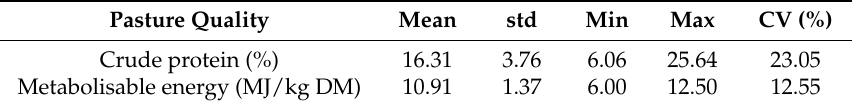
Table 1. Descriptive statistics: mean, standard deviation (std), minimum (min), maximum (max), and coefficient of variation (CV) pasture quality data was used to build a calibration model. Pasture Quality Mean std Min Max CV (%) Crude protein (%)